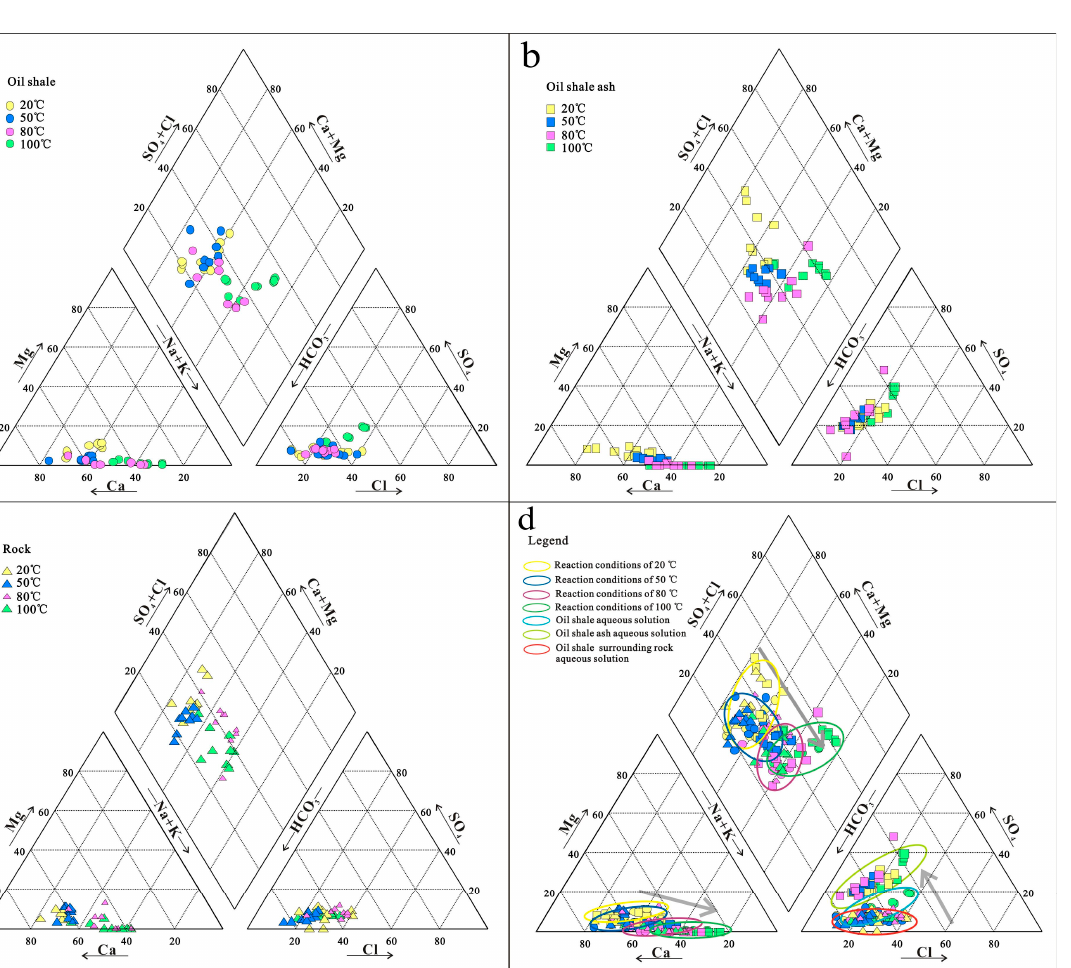
Figure 10. Piper ternary diagrams of water ‒ rock interactions in the aqueous solution with different reaction conditions. ( a – c ) show the chemical compositions of water–rock interactions in oil shale aqueous solution, oil shale ash aqueous solution and rock aqueous solution, respectively. ( d ) shows the chemical compositions of these there aqueous solutions together.